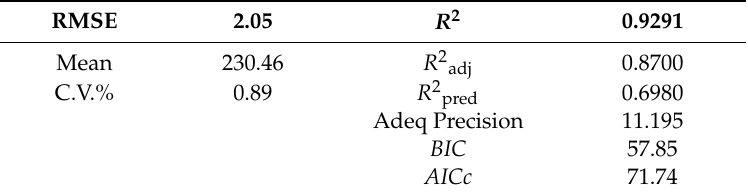
Table 6. Analysis of statistical variance.